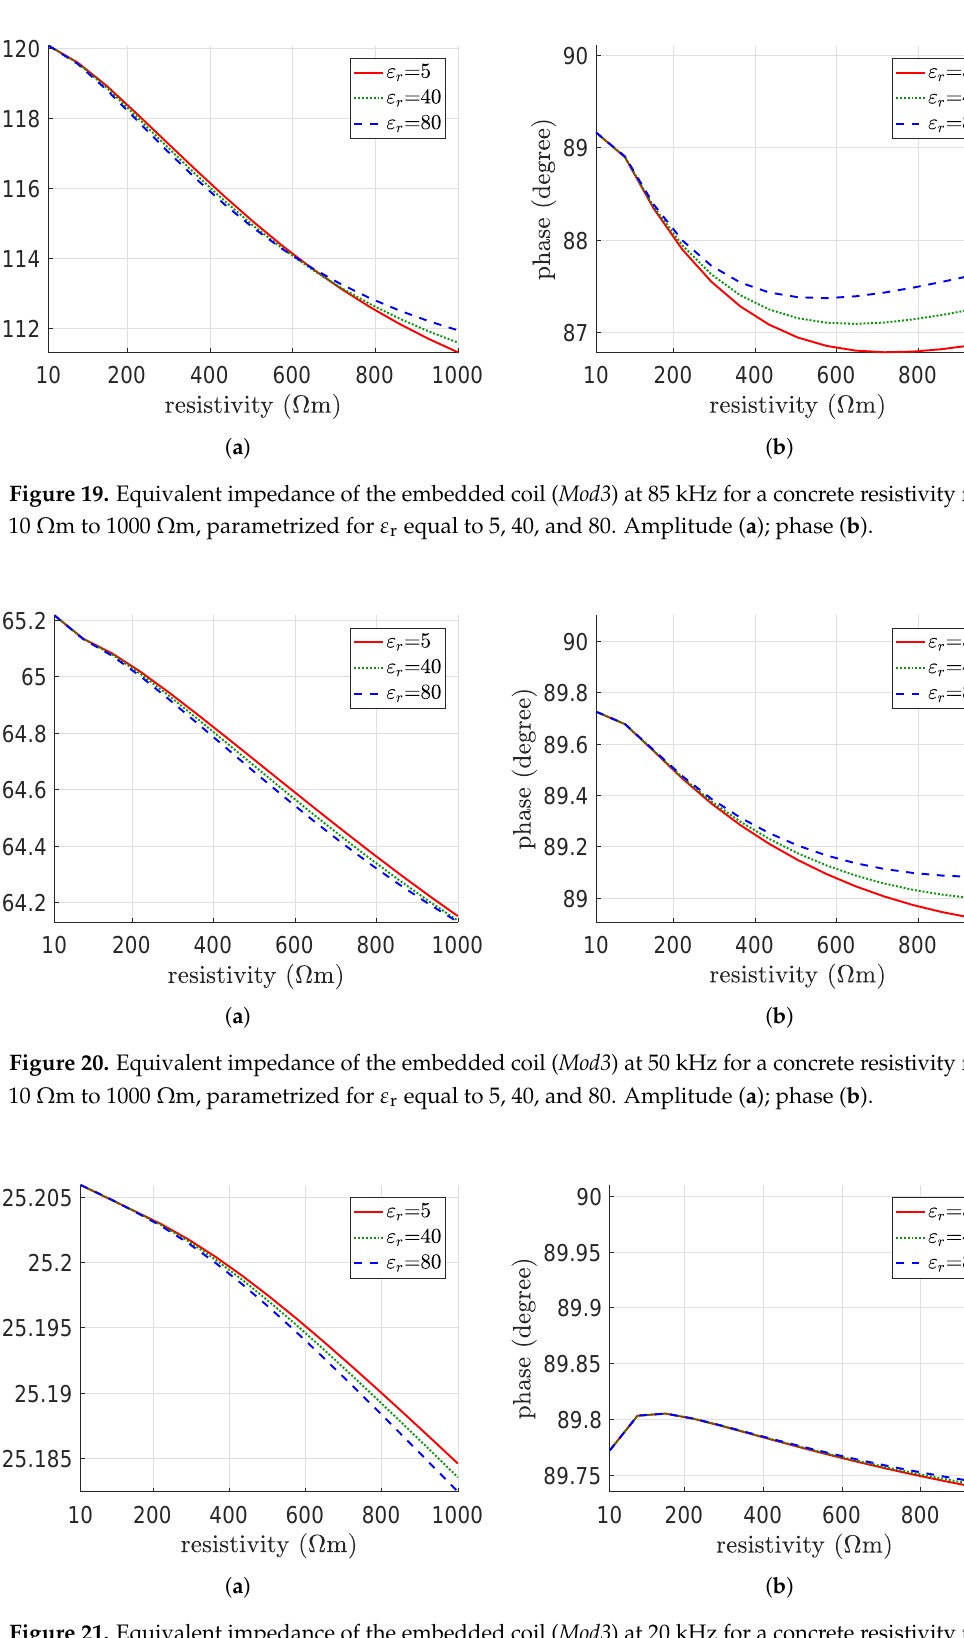
Figure 21. Equivalent impedance of the embedded coil ( Mod3 ) at 20 kHz for a concrete resistivity from 10 Ω m to 1000 Ω m, parametrized for ε r equal to 5, 40, and 80. Amplitude ( a ); phase ( b